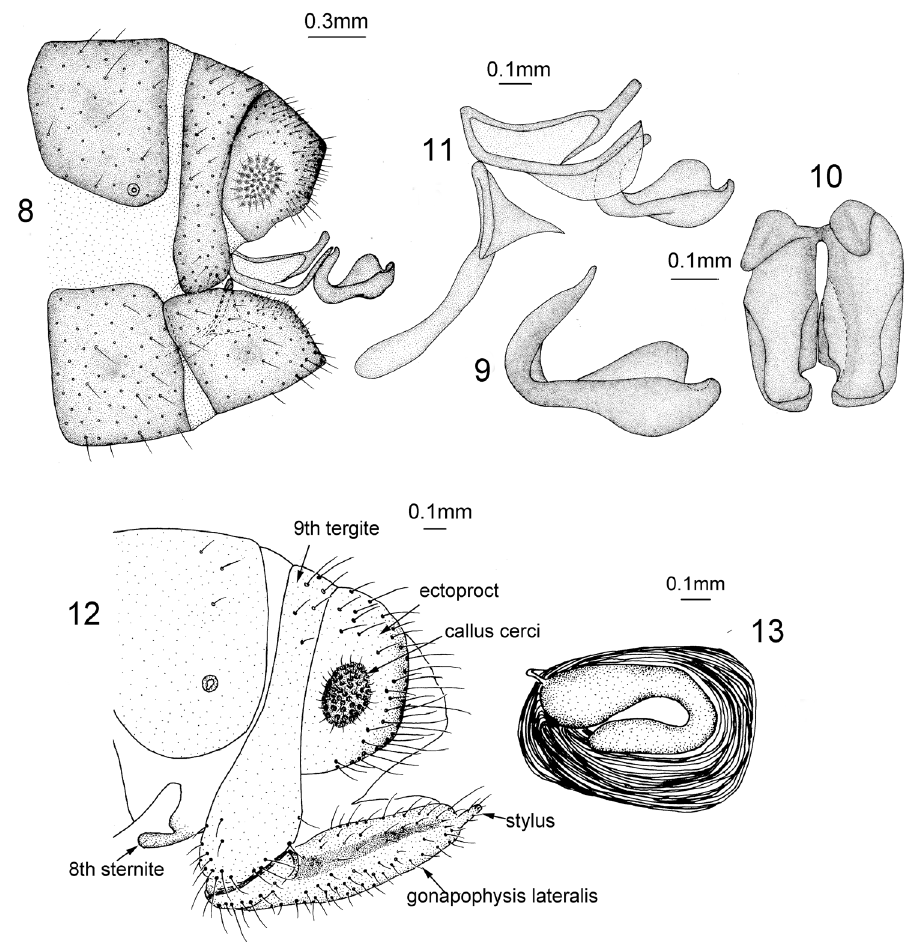
Figures 8–13. Heterosmylus yunnanus Yang, 1986. Male: 8 terminalia, lateral view 9 mediuncus, lateral view 10 mediuncus, dorsal view 11 genitalia, lateral view Female: 12 terminalia, lateral view 13 sper- matheca, lateral